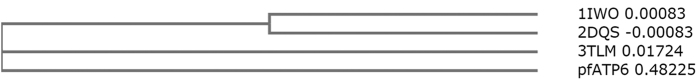
Phylogenetic tree.Phylogenetic tree shows the evolutionary relationship between malarial PfATP6 protein and template (3TLM, 1IWO, and 2DQS) protein sequences.